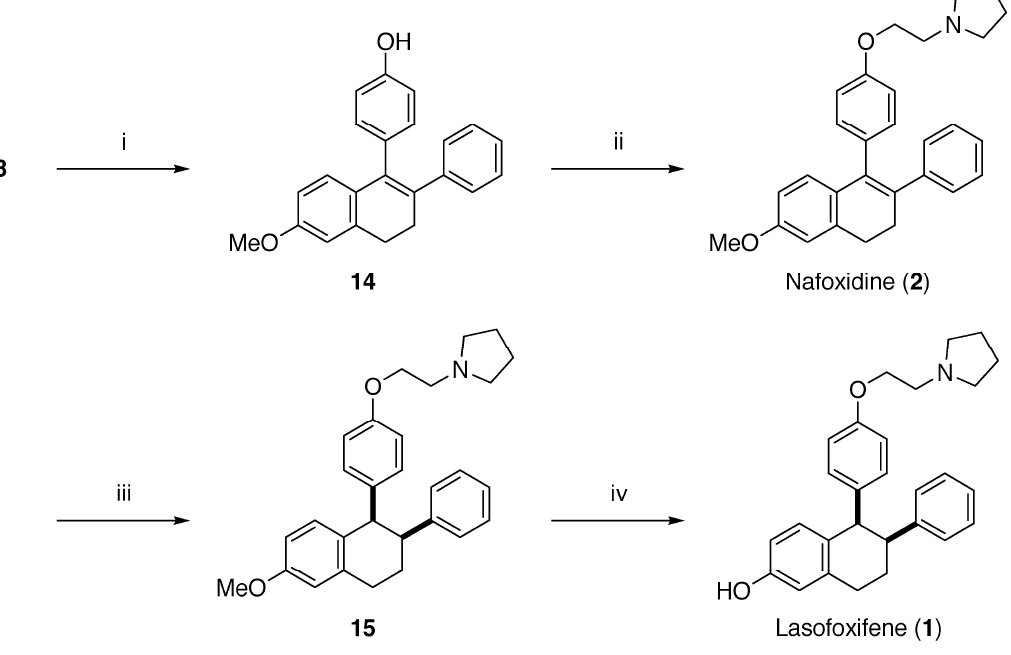
iodide intermediate 8 into the common precursor 14